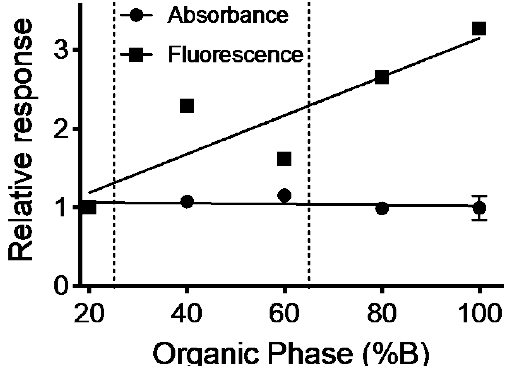
Figure A1. 5F-APINACA absorbance and fluorescence response as function of organic-phase content. Analytes from 5F-APINACA metabolism eluted during a gradient between solvent A (10% solvent